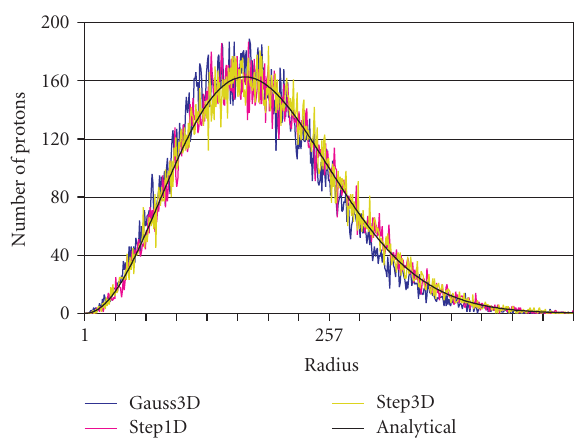
Figure 2: The radial spin position distribution shown after di ff u- sion at time interval TD. The protons all started from the origin at T = 0 and propagated in space corresponding to the di ff erent Monte Carlo step procedures Step1D, Step3D, and Gauss3D.